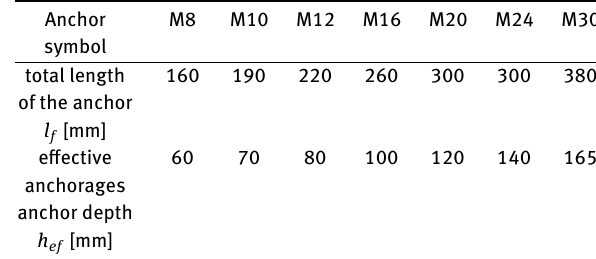
Table 2: Anchoring parameters for anchoring depth 6 x d according